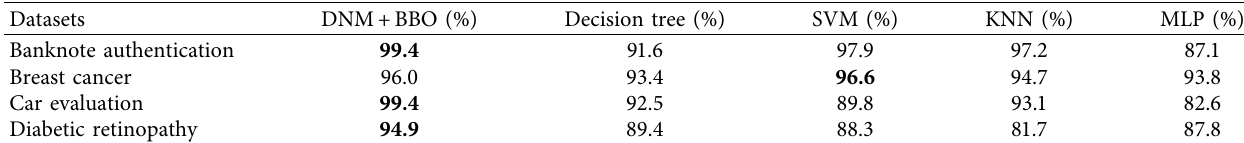
Table 6: Accuracy of DNM+BBO and other machine learning methods for the datasets of banknote authentication, breast cancer, car evaluation, and diabetic retinopathy.